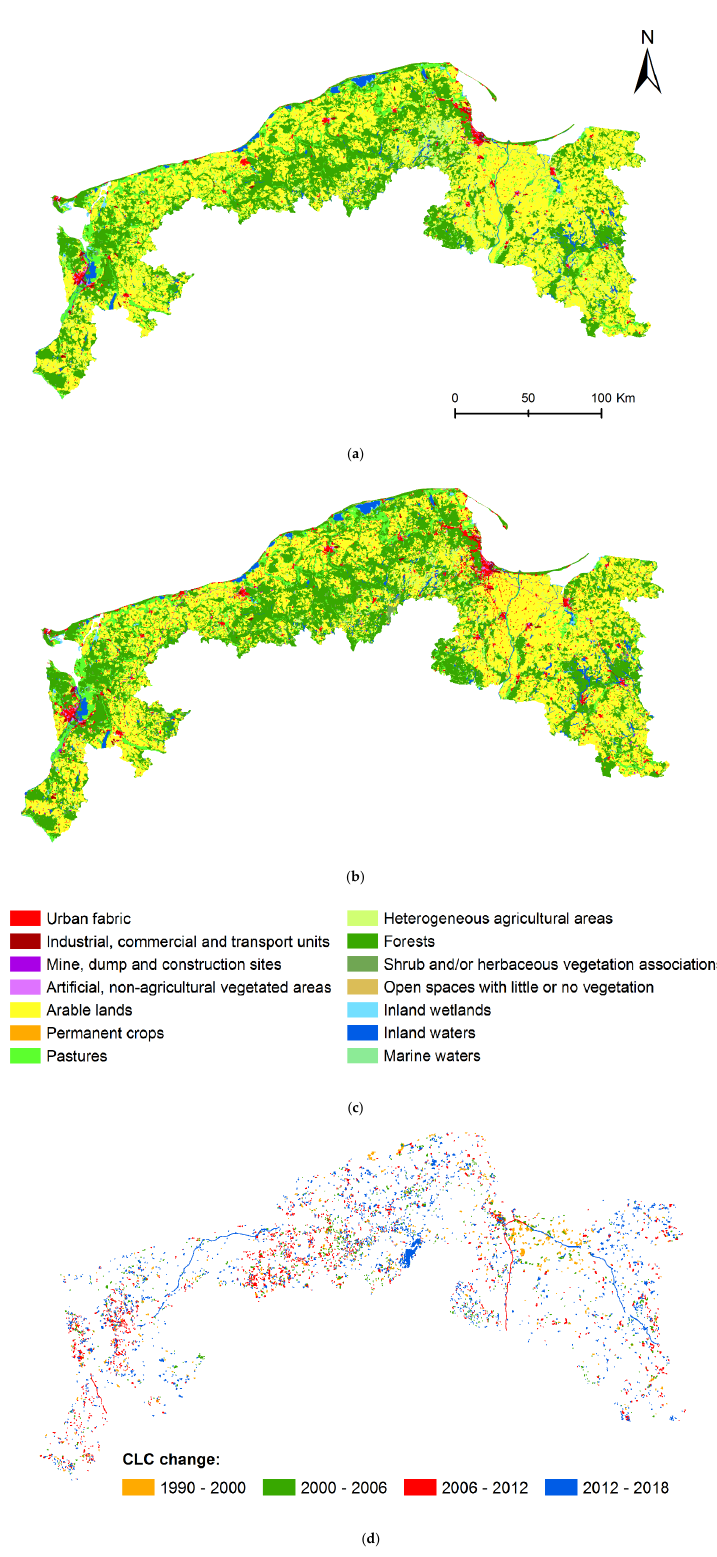
Figure A1. CORINE Land Cover types in Polish Baltic coastal zone in ( a ) 1990; ( b ) 2018; ( c ) CLC classes – level 2; ( d ) CLC changes in 1990–2018.